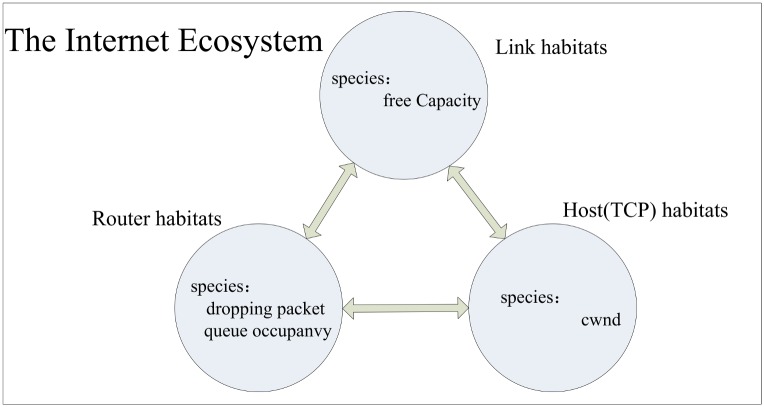
Internet ecosystem.